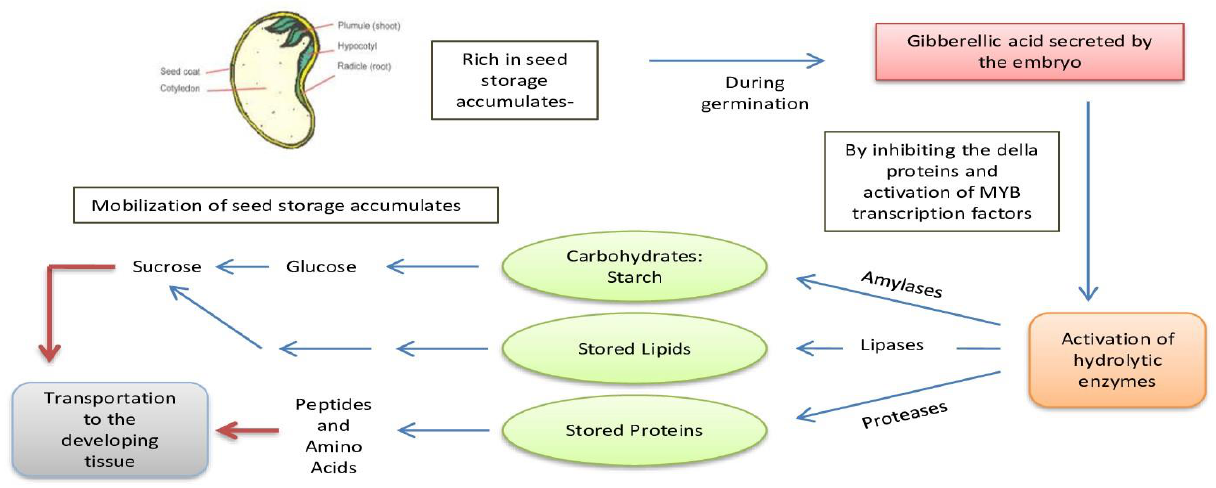
Figure 2. Generalized seed reserve mobilization in germinating seedlings. Stored Lipids